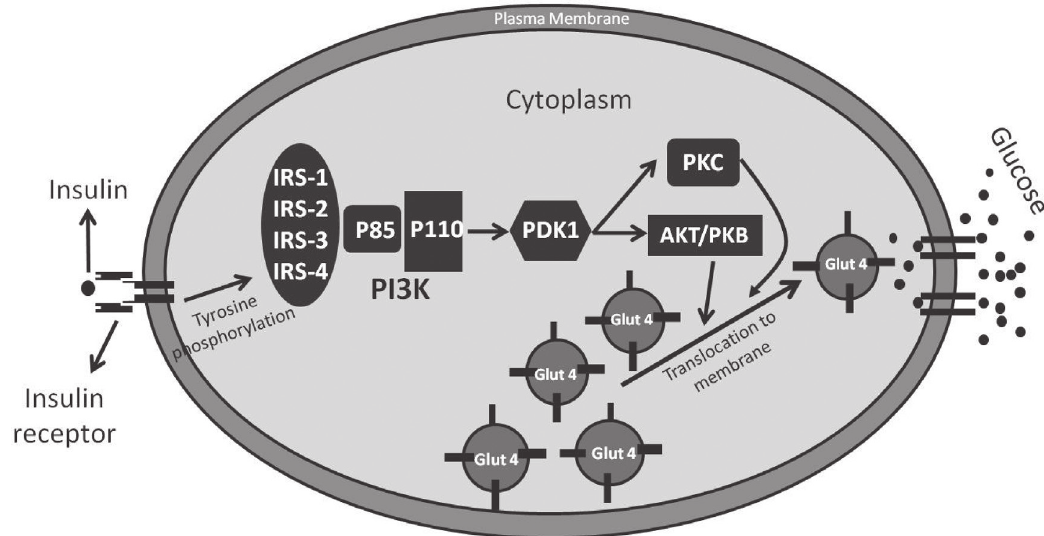
Figure 1 - The insulin activates a number of intracellular signaling proteins that are involved in the insulin-dependent glucose uptake mechanism [e.g., insulin receptor substrate (IRS), phosphatidylinositol-3-kinase (PI3K), regulatory subunit of PI3K (P85), catalytic subunit of PI3K (P110), phosphoinositide-dependent protein kinase 1(PDK1), protein kinase C (PKC), protein kinase B (PKB or AKT), and glucose transporters 4